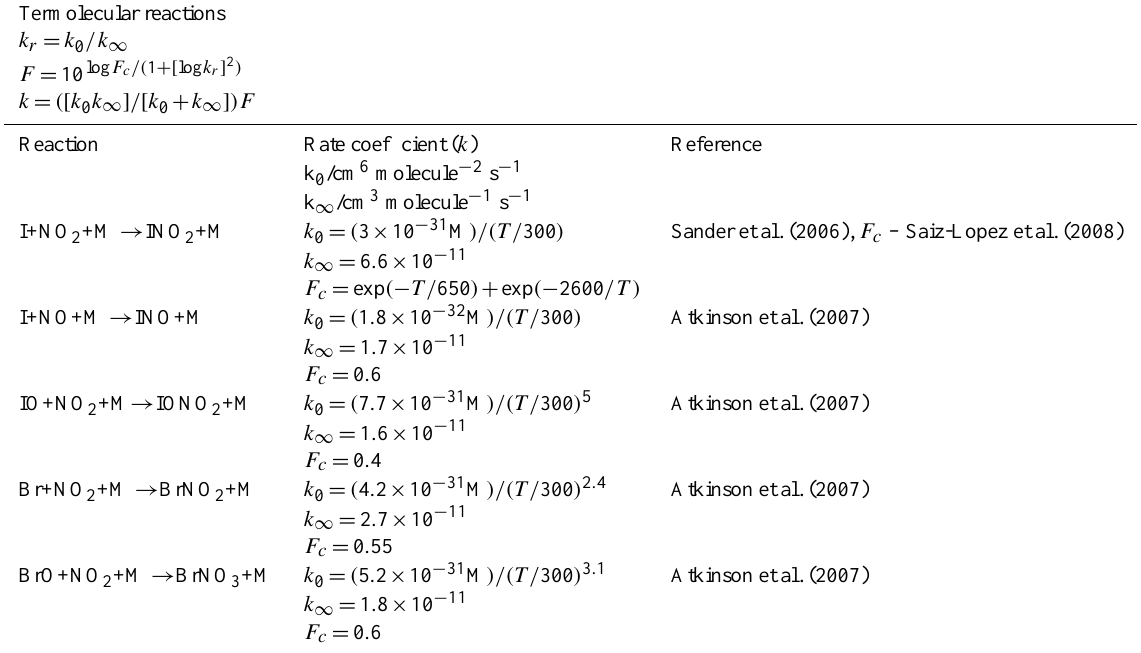
Table A3. Halogen chemistry reaction scheme – termolecular reactions.